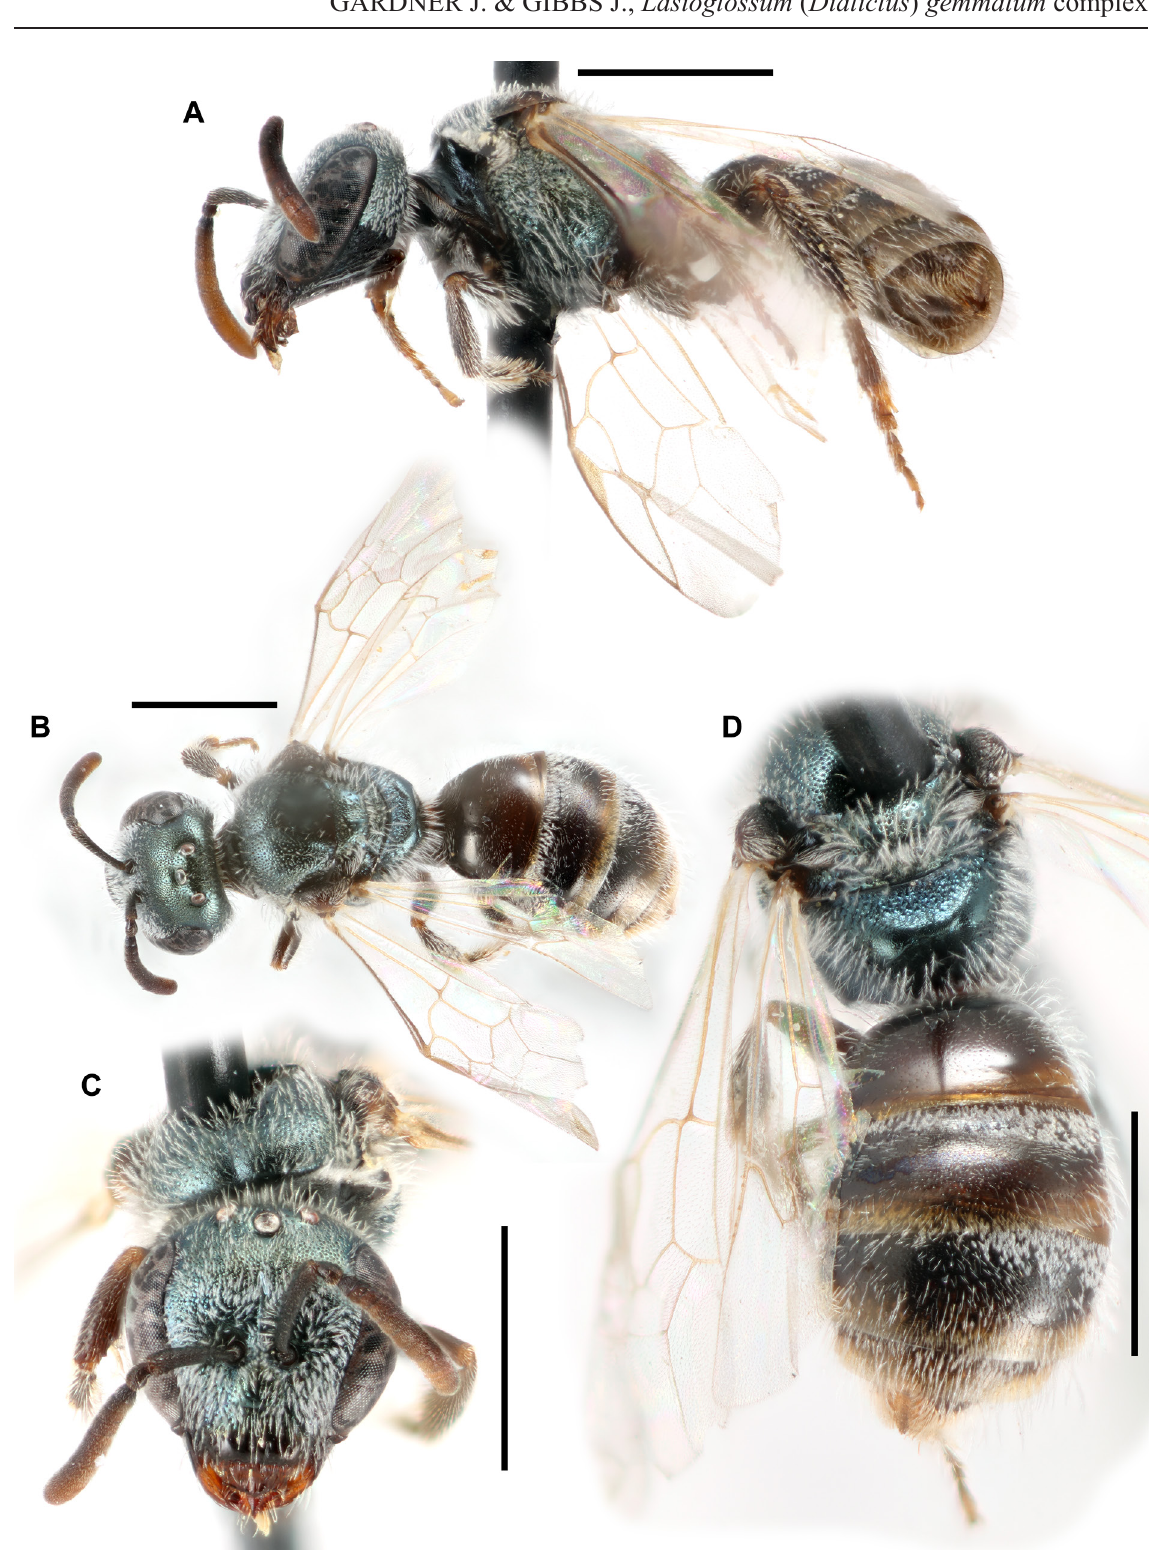
Fig. 24. Lasioglossum ( D .) gaudiale (Sandhouse, 1924), ♀ (UCMC 0260263). A . Lateral habitus. B . Dorsal habitus. C . Face. D . Metasoma and propodeum. Scale bars = 1